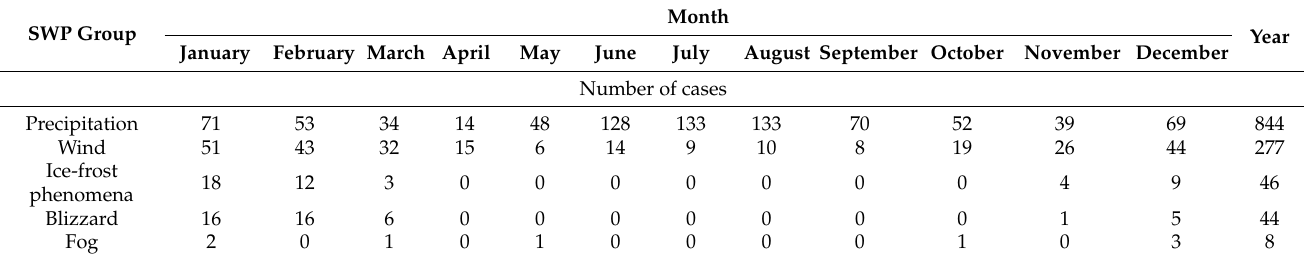
Table 2. Long-term averaged characteristics of SWP on the Crimean Peninsula using data of meteoro- logical network for the period